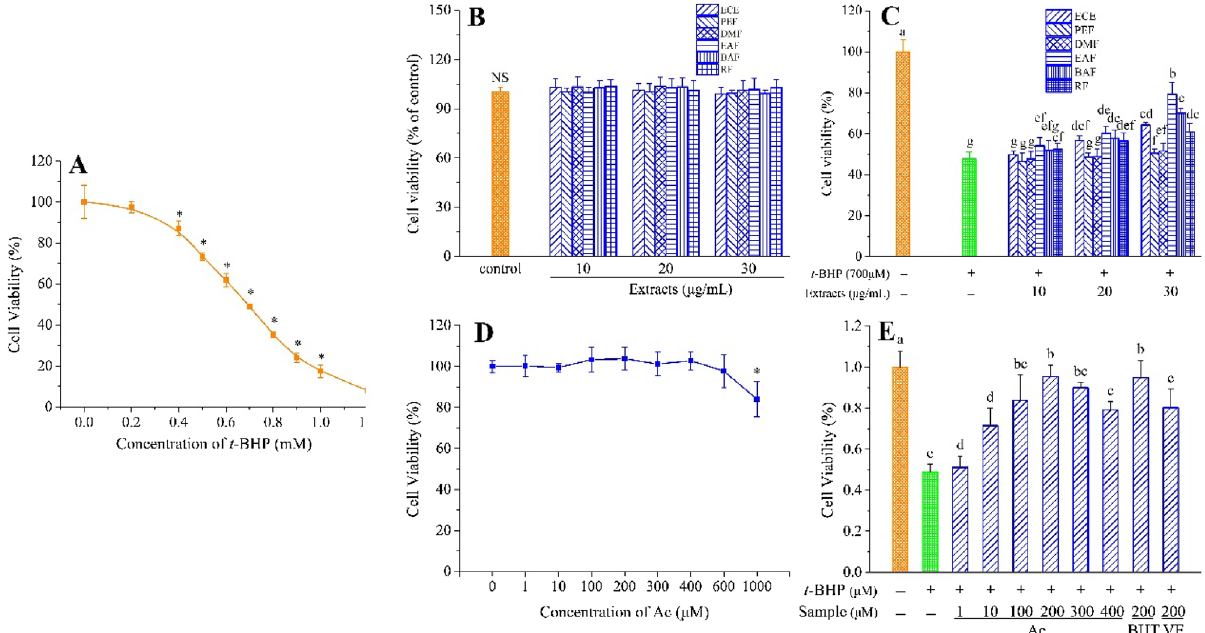
Figure 2. HepG2 cells viability. (A) Cells were treated with t -BHP at the indicated concentrations (0–1.2 mmol/L). *p < 0.05 compared with no t -BHP treatment. ( B ) Viability of HepG2 cells after treatment with different concentrations of ECE, PEF, DMF, EAF, BAF, RF. NS indicates that there is no significant difference between control and all sample groups (p < 0.05). ( C ) Cytoprotective effects of ECE, PEF, DMF, EAF, BAF, RF. ( D ) Viability of HepG2 cells after treatment with different concentrations of Ac. *p < 0.05 versus no Ac treatment. ( E ) Cytoprotective effects of Ac. Different letters above bars indicate significant difference (by ANOVA, p < 0.05). Result are expressed as mean ± SD (n ≥ 3). + , treated; −,